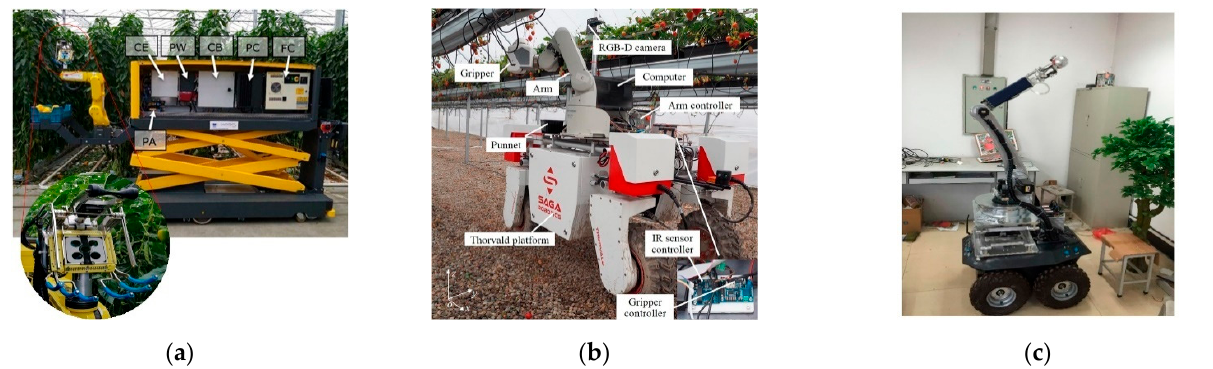
Figure 6. Harvesting robot. ( a ) is the sweet pepper harvesting robot [96]. ( b ) is the strawberry picking robot [97]. ( c ) is the apple-picking robot [ 100 ].